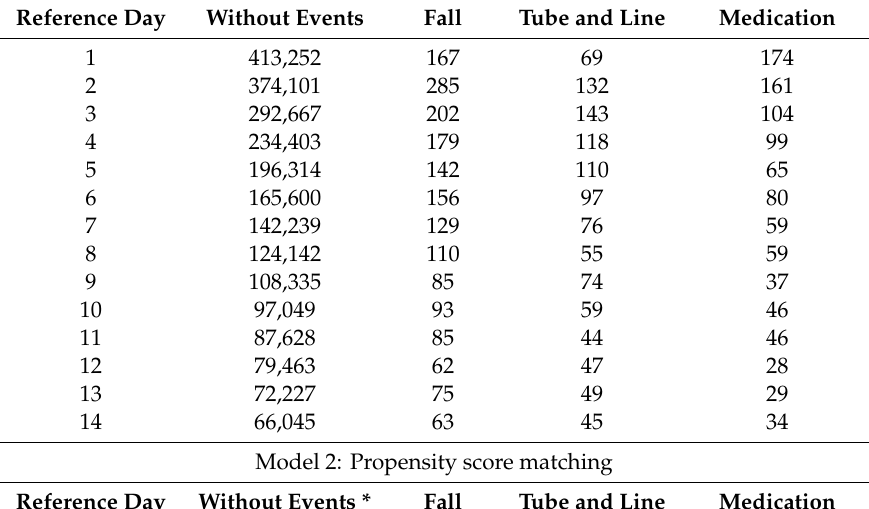
Table 3. Number of cases and controls (without events) of the analyses. Model 1: Multivariable linear